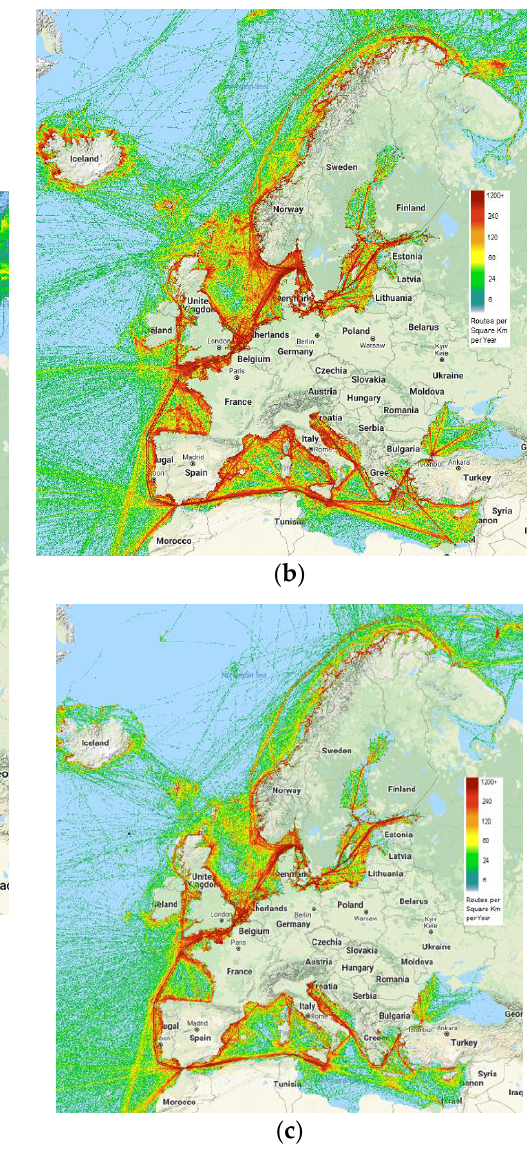
Figure 1. European Union vessel density map: ( a ) During the year 2019; ( b ) for July 2019; ( c ) for December 2019. [27].